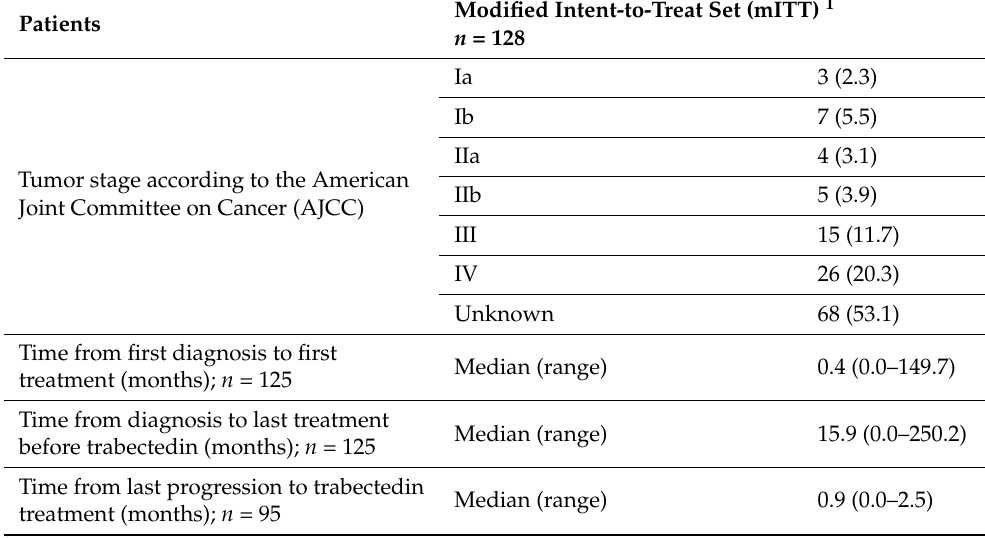
Table 1. Cont. Patients